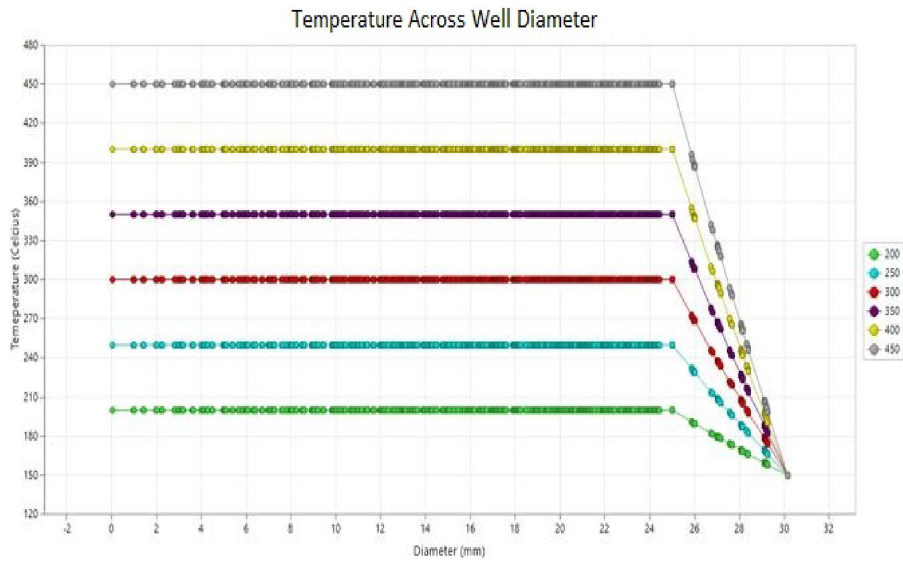
Fig. 10 Variation in pressure across the well internal